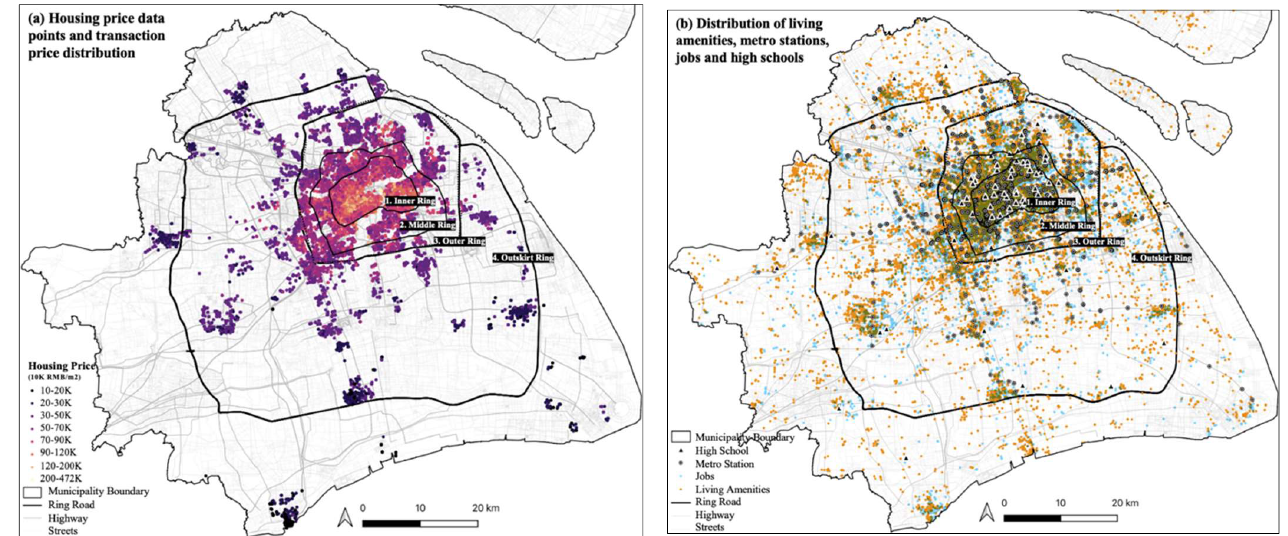
Figure 6. Spatial distribution of ( a ) 2019 transaction housing price data from HomeLink, and ( b ) neighborhood attributes including living amenities, metro station, job opportunities, and high schools. Table 2. General descriptive statistics of the housing characteristics.